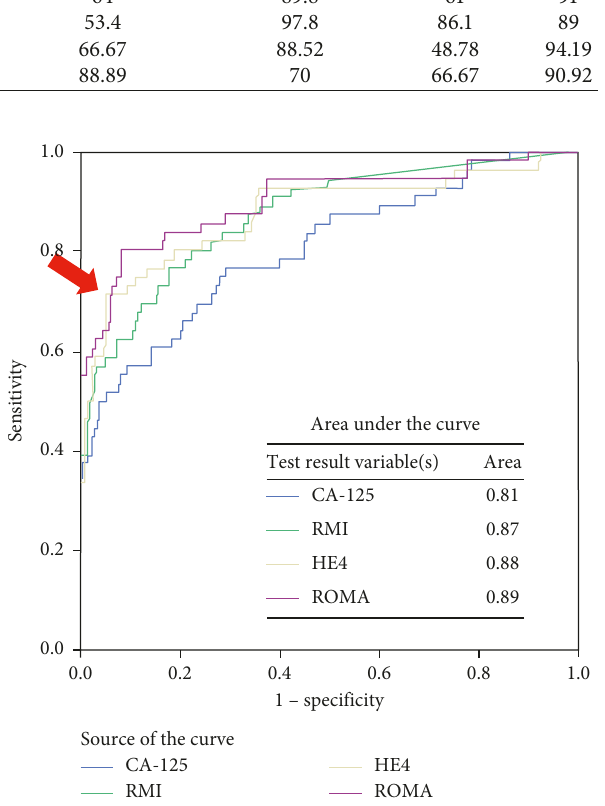
Figure 1: ROC curves and AUC of CA-125, RMI, HE4, and ROMA. The arrow points at the new cutoff point of HE4 at